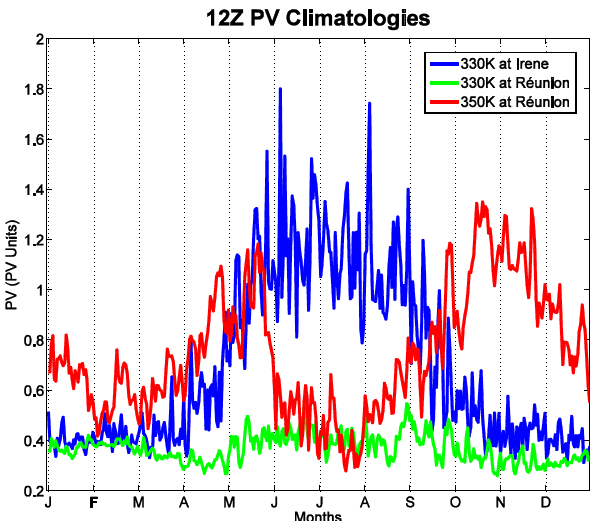
Figure 11. ECMWF potential vorticity (PV) daily climatologies over Irene for 330K and Réunion for 330K and 350K calculated, respectively, over 1990–2007 and 1992–2011, by averaging day-of- year